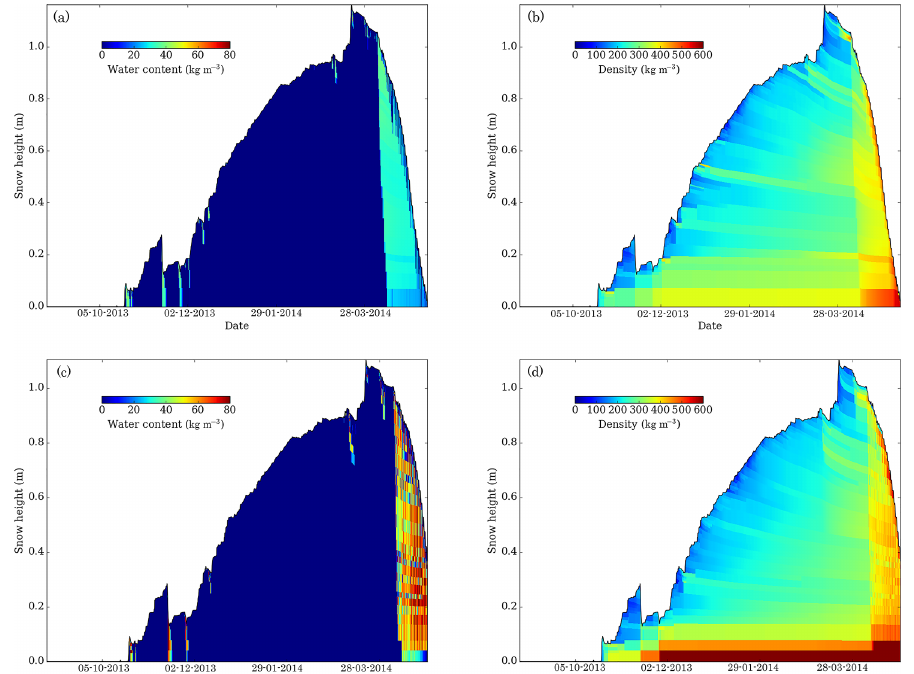
Figure 6. Crocus output from Filefjell, Norway, in which the top plots use the bucket routine and the bottom plots use the Richards routine. Panels (a, c) show distribution of liquid water, and (b, d) show the density distribution. T crocus = 900s (15min) was the time step duration.